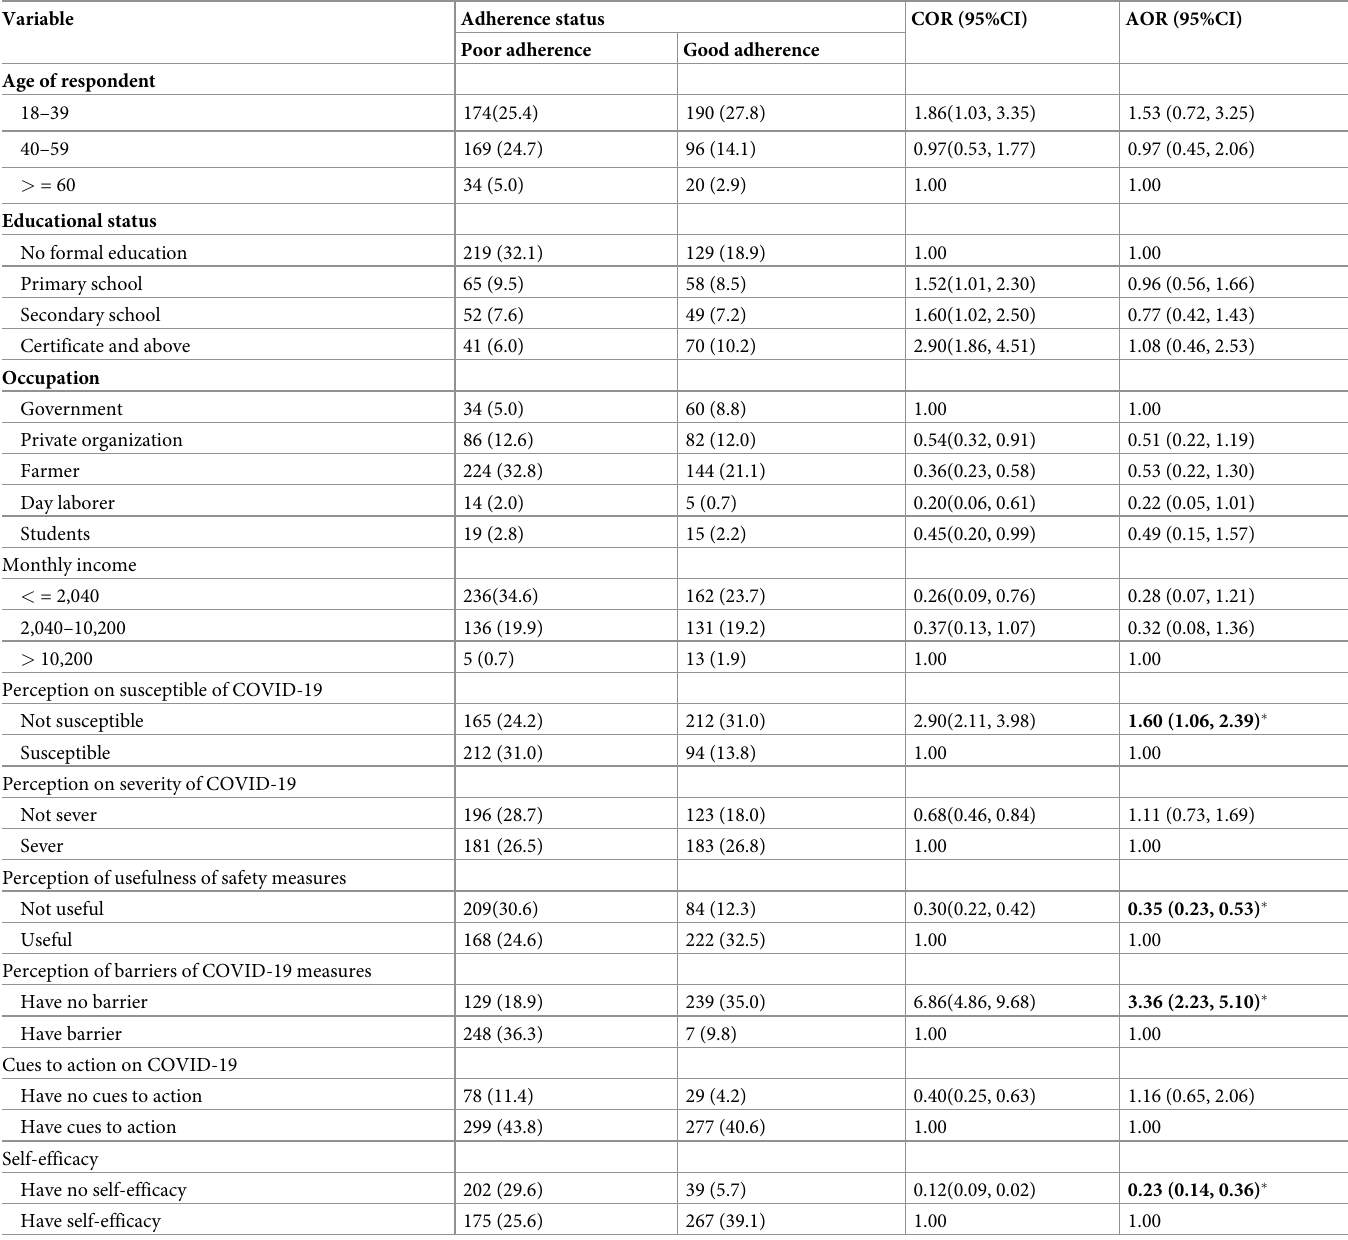
Table 7. Multivariate analysis of adherence status on recommended safety measures of COVID-19 among community in North Shoa zone, Ethiopia 2020.